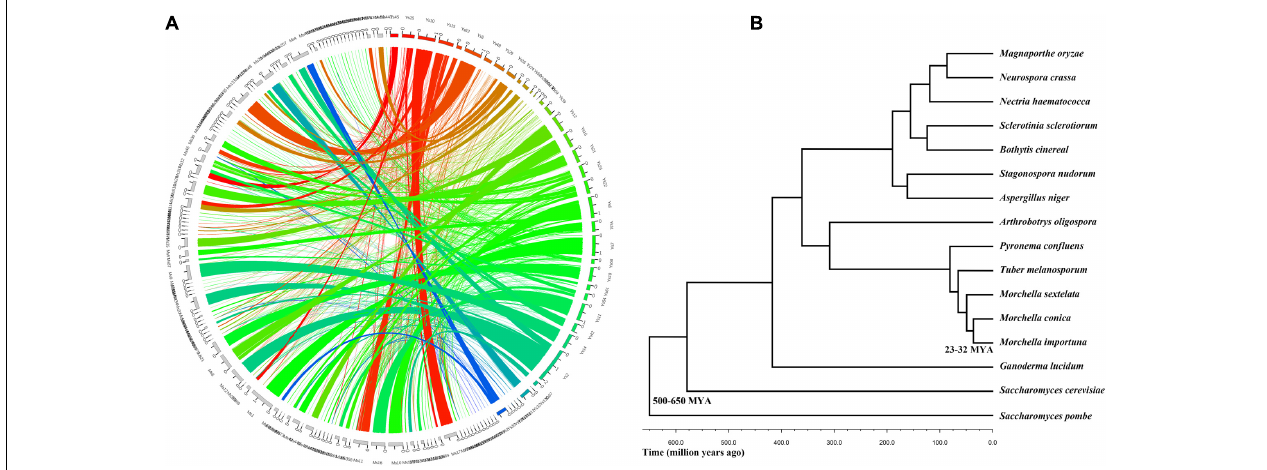
FIGURE 1 | Evolutionary relationship between Morchella conica SH and other related fungal species. (A) Genome synteny in Morchella . Circos plot showing syntenic regions in two Morchella species ( M. conica SH in colored blocks, Morchella importuna in gray blocks). One syntenic block is considered only if at least two orthologous genes are present in the same order. The yellow, green, and blue links correspond to syntenic blocks composed of > 10, 5–10, and < 5 genes, respectively. (B) The phylogenetic tree of Morchella and 13 other species in the context of fungi.